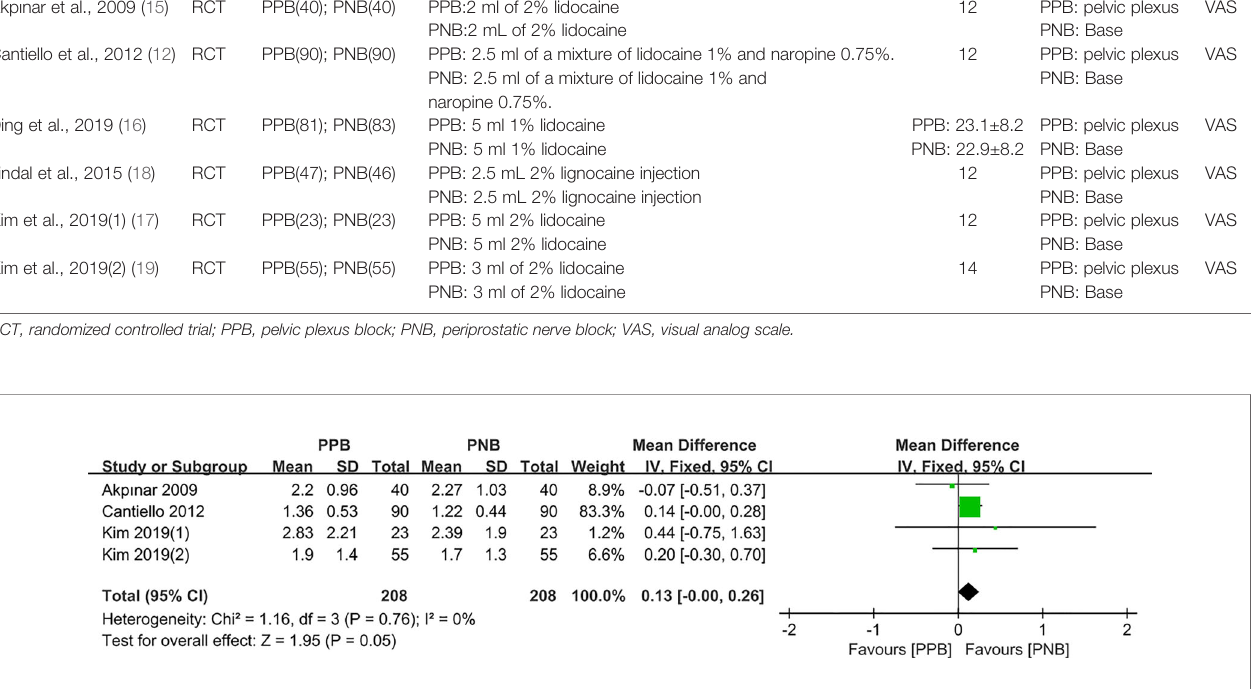
FIGURE 2 | Forest plot comparing VAS score-probe insertion in patients receiving PPB vs PNB.